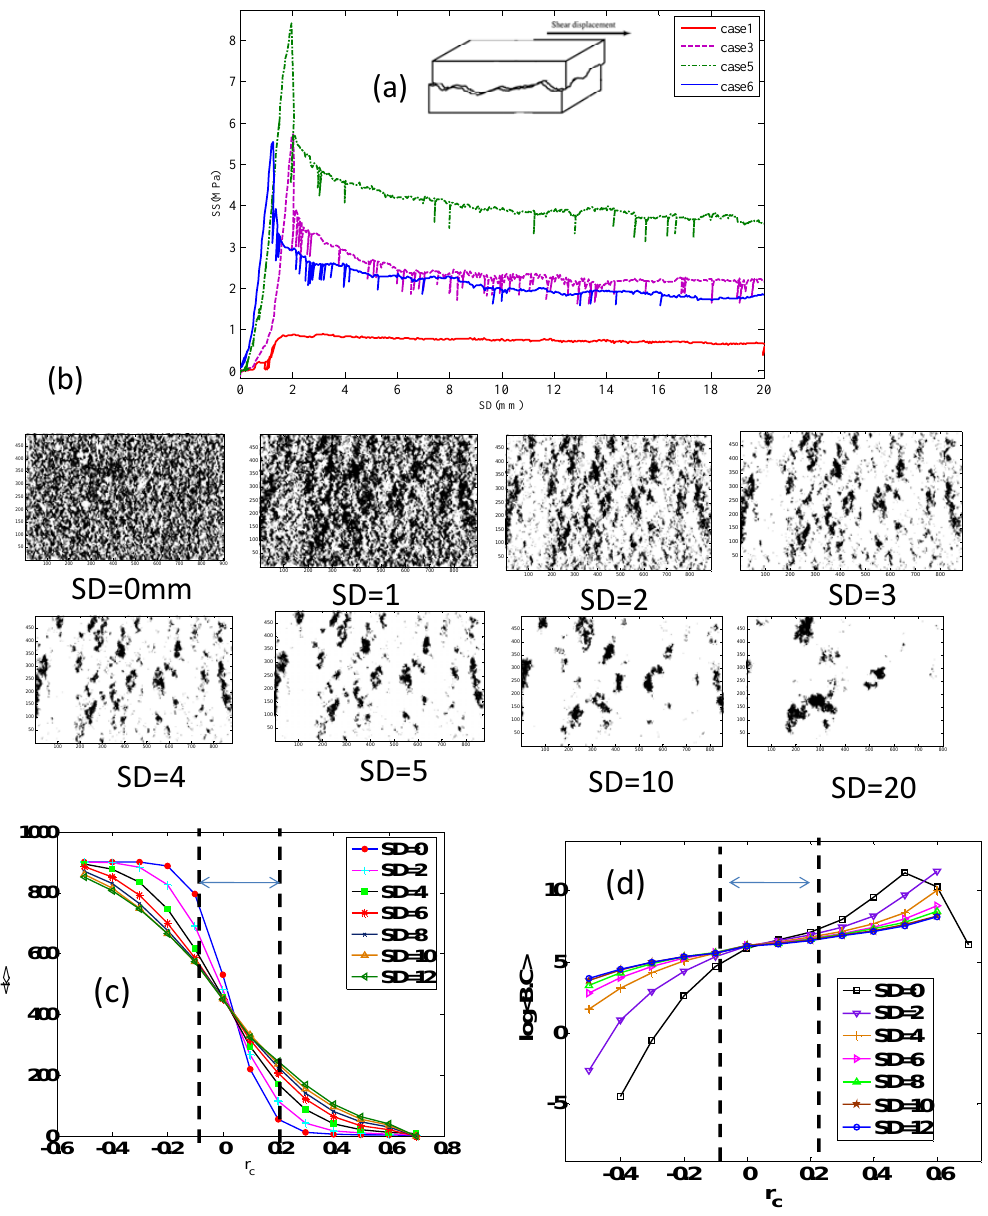
Figure 1. a) Shear strength for different cases (SD=Shear Displacement in mm; normal Fig. 1. (a) Shear strength for different cases (SD=Shear Displacement in mm; normal stresses for case 1: 1Mpa, case 3: 3MPa, case 5: 5MPa and case 6: 3MPa (without control of upper shear box-Data set courtesy of M. Sharifzadeh); (b) Contact zones (black) and non- stresses for case1:1Mpa, case3: 3 MPa, case5: 5 MPa and case6: 3 MPa (without contact areas during the evolution of a frictional interface (case 3); (c) density of edges versus threshold level and (d) natural logarithmic control of upper shear box-Data set courtesy of M.Sharifzadeh); b) Contact zones variation of mean betweennness centrality (B.C) with truncation value. The indicated interval with arrows shows the best possible threshold level where the minimum variation of log < B.C > occurs (the most stable-dominant structures). < ... > indicates average over all nodes (i.e. (black) and non-contact areas during the evolution of a frictional interface (case 3) ;(c) aperture density of edges versus threshold level and d) natural logarithmic variation of mean